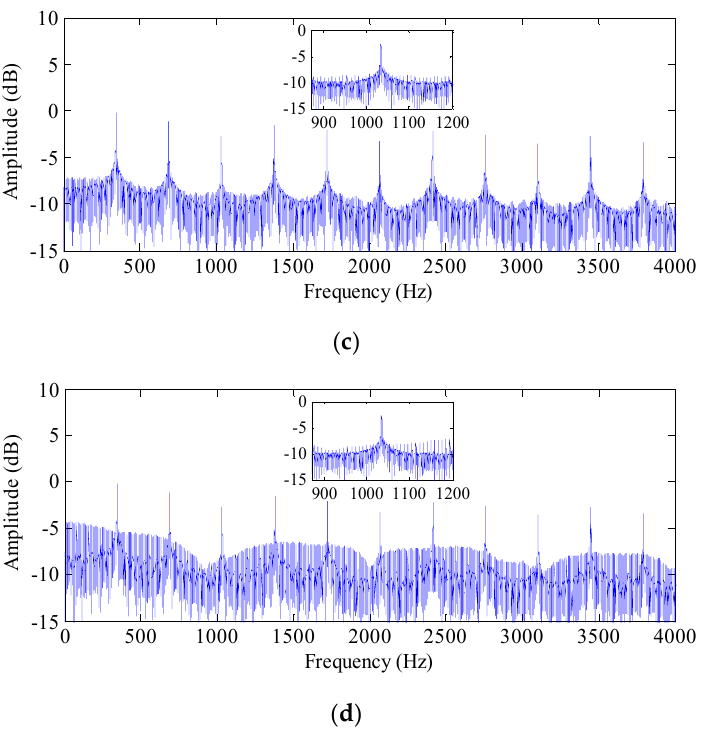
Figure 13. DTE spectra of different fault cases: ( a ) case #1, ( b ) case #2, ( c ) case #3, ( d ) case #4.